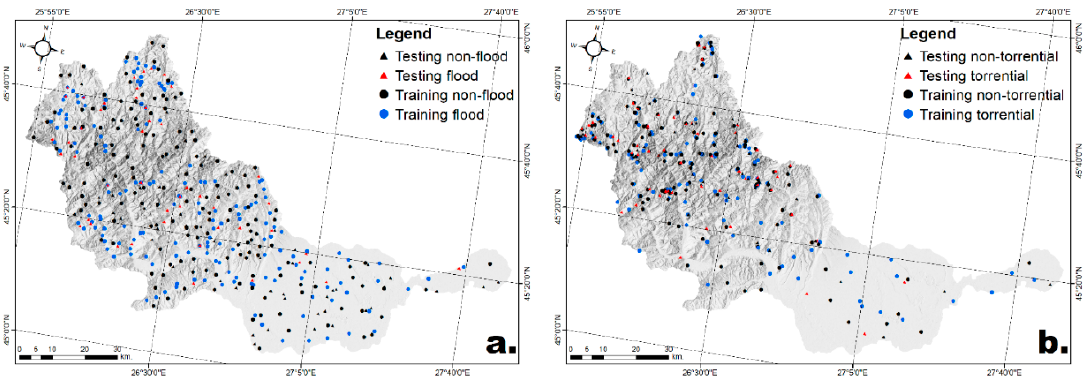
Figure 2. Location of flood and torrential areas ( a ) Flood / non-flood locations; ( b ) Torrential / non-torrential locations).